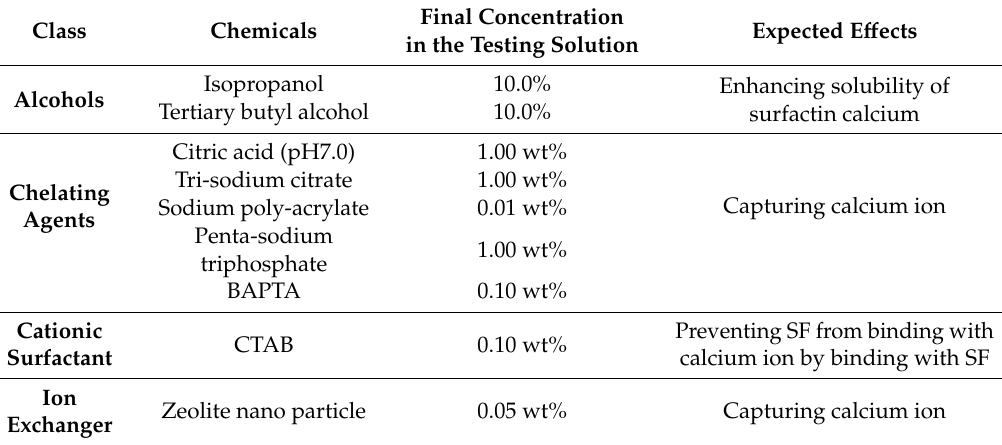
Table 1. Candidates of the inhibitor examined in this